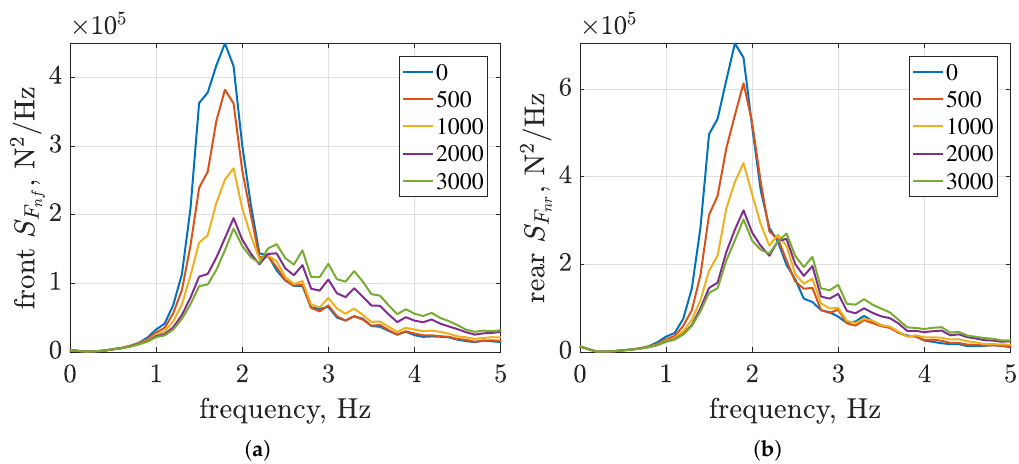
Figure 14. Power spectral density characteristics of wheel normal forces for Skyhook control of suspension parts (Skyhook-1DOF) and vehicle longitudinal velocity equal to 5 ms − 1 : ( a ) front wheel, ( b ) rear wheel.